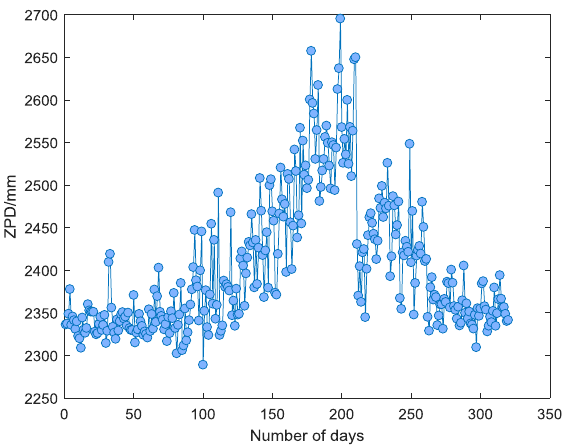
Figure 2. The zenith path delay (ZPD) variations at the BJFS International GNSS Service (IGS) station in 2016.